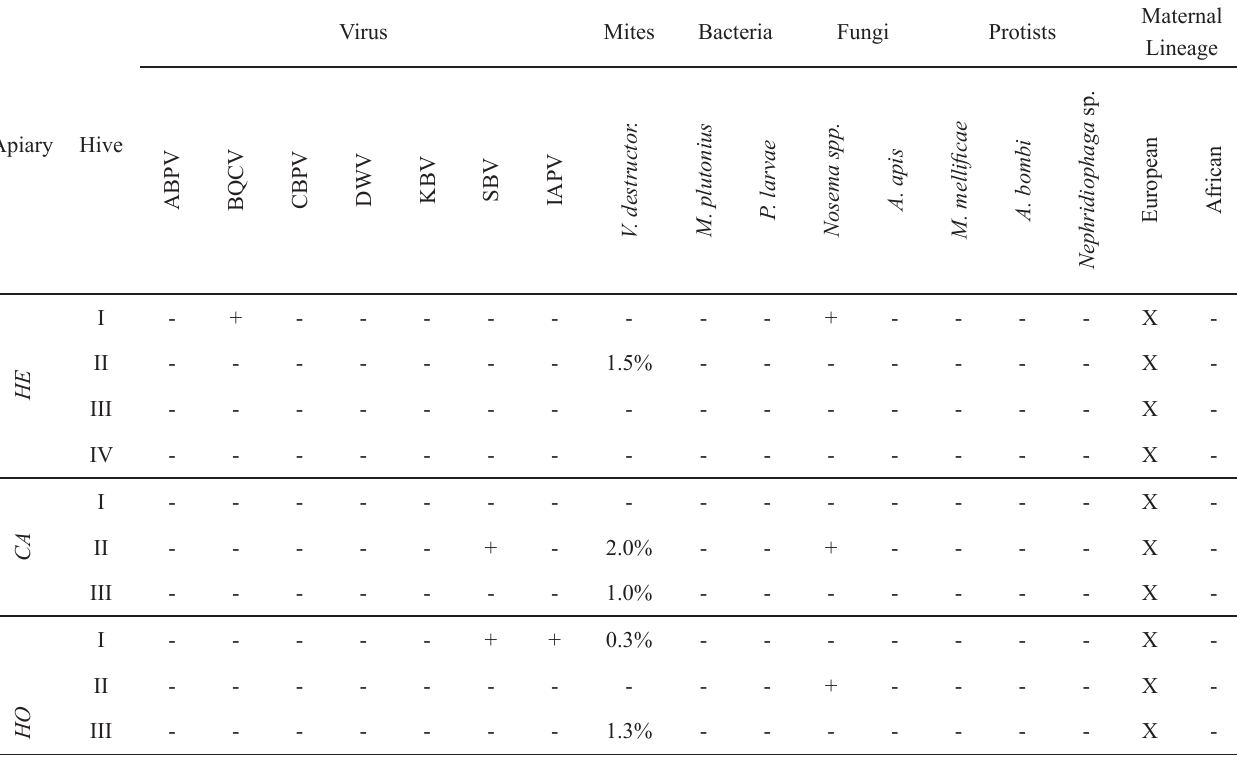
Table 2 . Analyses of A. mellifera from General Alvear, Buenos Aires, Argentina: Presence of pathogens and maternal lineage determination. Results are expressed as (+) for those pathogens present in the sample and (-) for those that did not exhibit presence. Maternal lineage is indicated with (x). [ A. bombi = Apicystis bombi ; ABPV = Acute Bee Paralysis Virus ; BQCV = Black Queen Cell Virus ; CBPV = Chronic Bee Paralysis Virus ; DWV = Deformed Wing Virus ; IAPV = Israeli Acute Paralysis Virus ; KBV = Kashmir Bee Virus ; M. mellificae